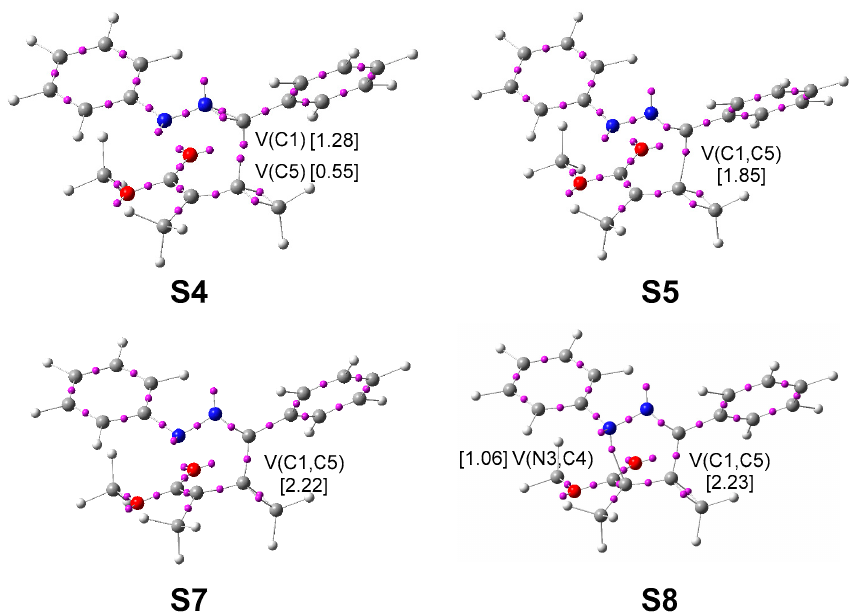
Figure 6. Attractor positions of the ELF valence basins of the selected structures involved in the C1– C5 and N3–C5 single bond formation along the most favourable reaction path associated with the 32CA reaction of diphenyl NI 1 with allenoate 4 . Electron populations, in average number of electrons, e, are given in brackets.